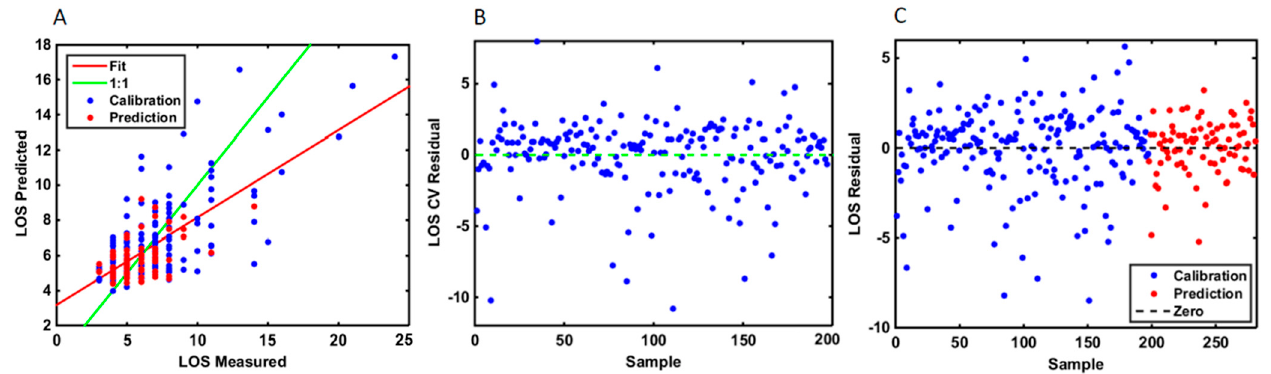
Figure 4. ( A ) Comparative curve analysis showing the measured and the predicted values for the calibration and prediction samples using the LOS as a continuous variable. The plot suggests that the ANN model had the optimal calibration power for LOS prediction. ( B ) Residual plot for LOS using predicted samples in cross-validation methodology. A residual is a measure of how far away a point is vertically from the regression line. Simply, it is the error between a predicted value and the observed actual value. The residual plot has the residual values on the y -axis and the inde- pendent variable on the x -axis. A good residual plot has a high density of points close to the origin and a low density of points away from the origin. It is symmetric about the origin showing the re- sidual errors are approximately distributed in the same manner. ( C ) Residual plot of the differences between the observed data values and the ANN model predicted values for the calibration and the prediction samples. 4. Discussion To the best of our knowledge, this study is the first to construct optimal data-driven ML/DL models to accurately predict and comprehensively quantify postoperative LOS in HGSOC patients. Such predictive models have already tested the intra-institutional per- formances, and shown to improve surgical morbidity and mortality by 45% and 31%, respectively [30]. Our approach allowed for the comparison of selected ML algorithms to identify the method with the most favorable performance for predicting LOS at various time points. Different definitions for prolonged LOS were interrogated for the differential binary classification predictions. Α definition of prolonged LOS as longer than the me- dian LOS may help models achieve better generalizability. Not surprisingly, conven- tional regression performance was comparable with ML/DL performance, likely due to class imbalance and varying degrees of collinearity. Arguably, LR was easy to imple-